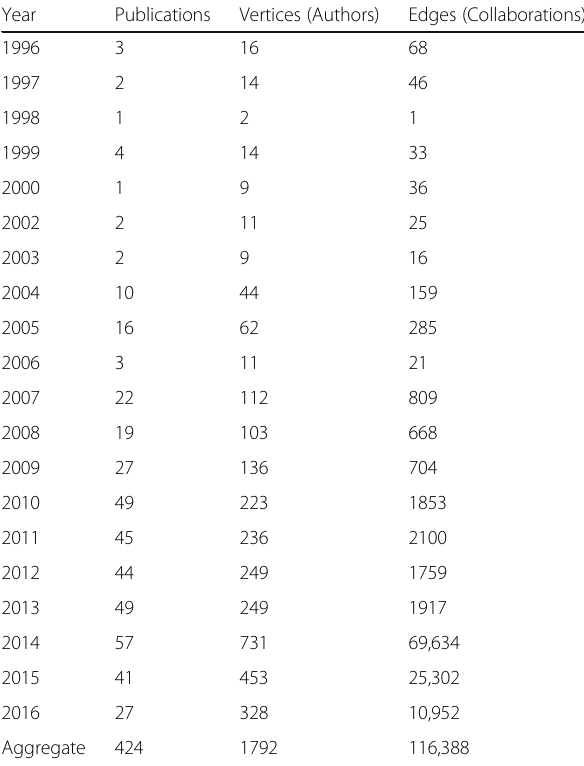
Table 2 Distribution of published documents, authors and collaborations from January 1996 to December 2016